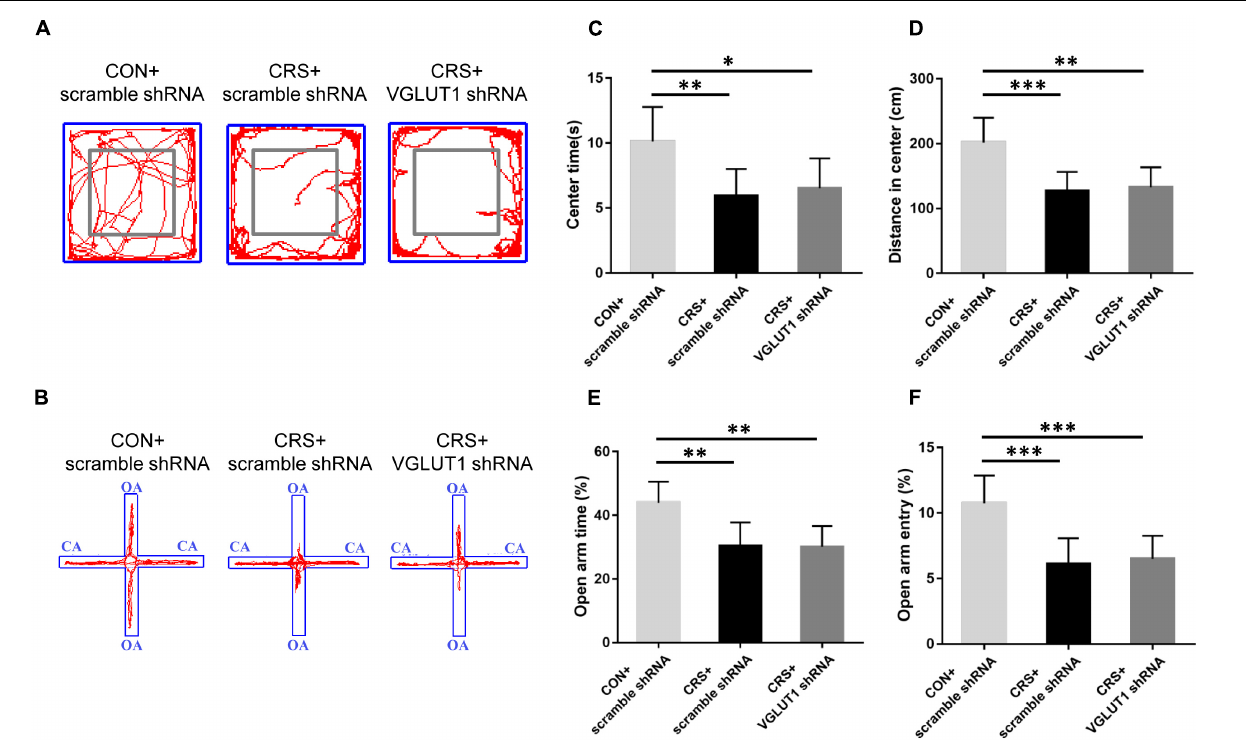
FIGURE 5 | Effects of VGLUT1 shRNA vector injection on behavioral changes in mice. Representative movement trials of mice from the CON + scramble shRNA, CRS + scramble shRNA and CRS + VGLUT1 shRNA groups in the OF (A) and EPM (B) tests ( n = 6/group). The gray square frames represent the center area in the OF. OA: open arm. CA: closed arm. Both CRS + scramble shRNA and CRS + VGLUT1 shRNA mice spent less time in the center area (C) and traveled a shorter distance in the center area (D) in the OF test than the CON + scramble shRNA mice and had lower percentages of time spent in the open arms (E) and entries into the open arms (F) in the EPM test than the CON + scramble shRNA mice. ∗ P < 0.05, ∗∗ P < 0.01, ∗∗∗ P <